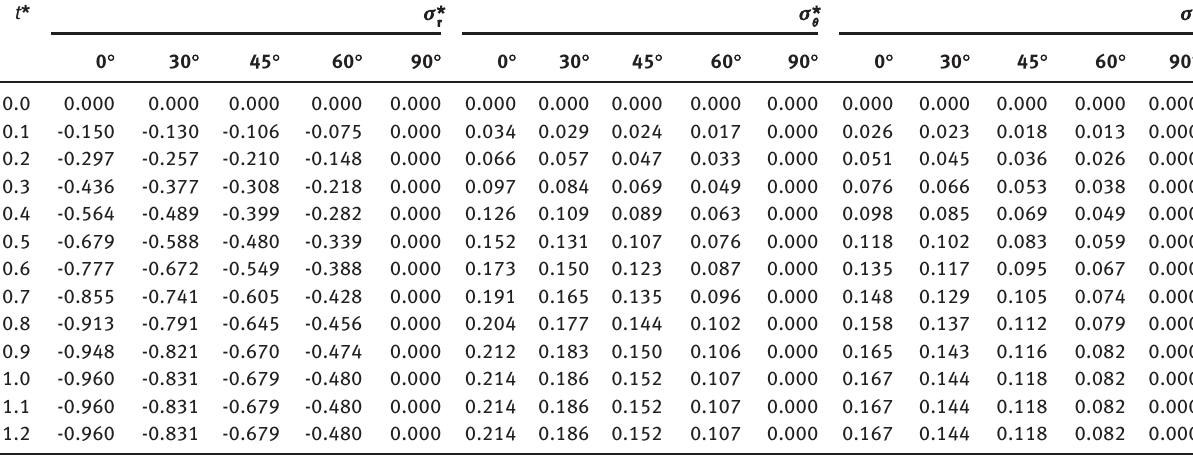
Table 4 Time histories of non-dimensional radial, tangential and axial stress components at points on the inner surface of the shell mid-length and different angular